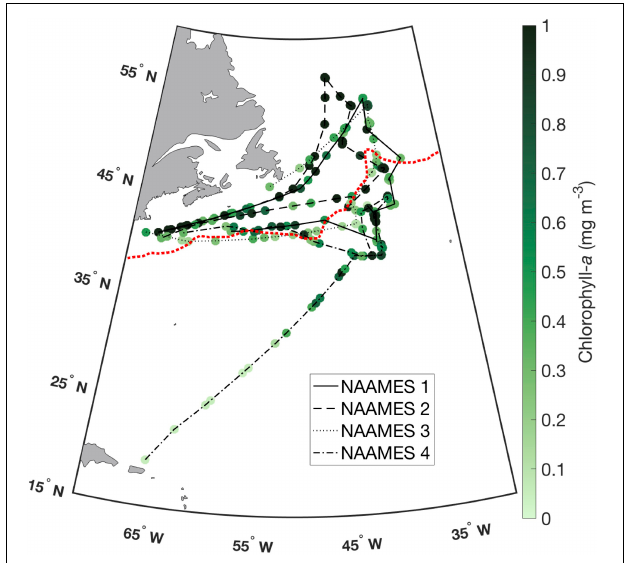
FIGURE 1 | Surface ocean total chlorophyll- a concentration from HPLC ( N = 229) on NAAMES 1 (solid line), NAAMES 2 (dashed line), NAAMES 3 (dotted line), and NAAMES 4 (dash-dot line). Subpolar (north of dashed red line) and subtropical (south of dashed red line) provinces are delineated as defined by Della Penna and Gaube (2019).